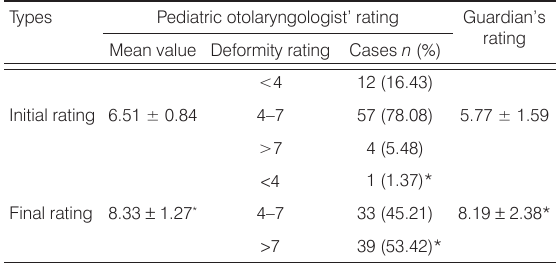
Table 1. Rating results comparison of the auricle deformity before and after the